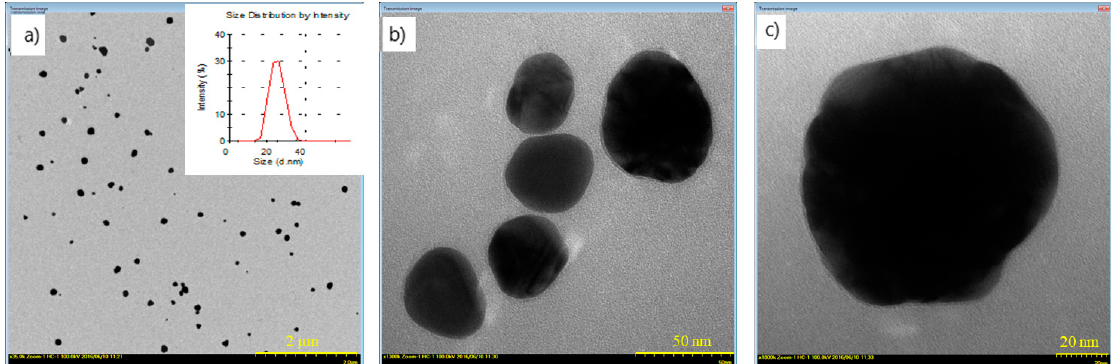
Figure 3. Transmission electron microscopy (TEM) images of CS/AgNp solution and Ag particle size distribution for scale: ( a ) 2 µm; ( b ) 50 nm; ( c ) 20 nm.